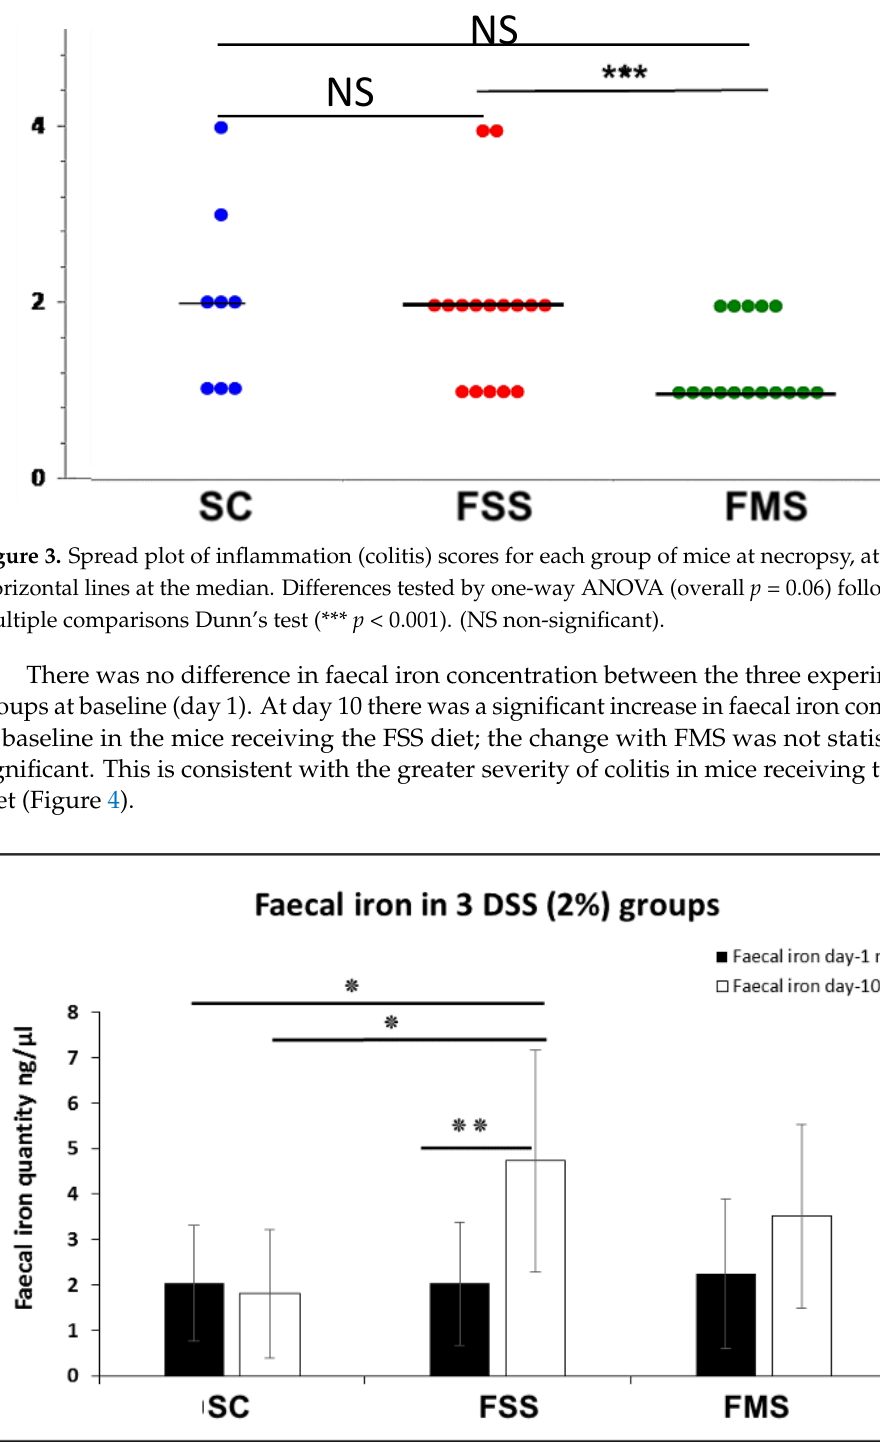
Figure 4. Faecal iron concentration at two different time points (day 1 and 10) for three DSS-treated groups of mice (SC, FSS and FMS diets). Data are presented as a mean ± standard error of the mean. Differences were tested by t-test (inter-comparison) and by one-way ANOVA (intra-comparison) followed by post hoc test. (* p < 0.05, ** p < 0.01).